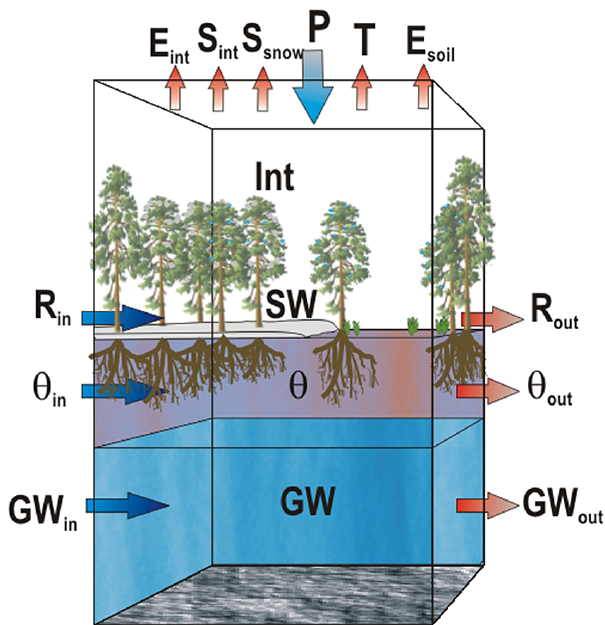
Figure 8. Soil column water balance storages and fluxes of a typ- ical hillslope computational element. The computational element’s Voronoi geometry has been represented by a rectangular shape in the interest of simplification. Water is mostly stored through vege- tation interception (Int), snow accumulation (SW), vadose zone soil moisture ( θ ) and groundwater in the saturated zone (GW). Surface and subsurface water (in and out) fluxes include above canopy gross precipitation ( P ), vegetation transpiration ( T ), evaporation from in- tercepted water ( E int ), evaporation from soil ( E soil ), sublimation from intercepted ( S int ) and on-the-ground snow ( S snow ), net sur- face ( R = R in − R out ) and subsurface runoff ( θ f = θ in − θ out ) and net groundwater flow (GWf = GW in − GW out ). The column is con- strained by an impervious bedrock layer, whose depth varies from element to